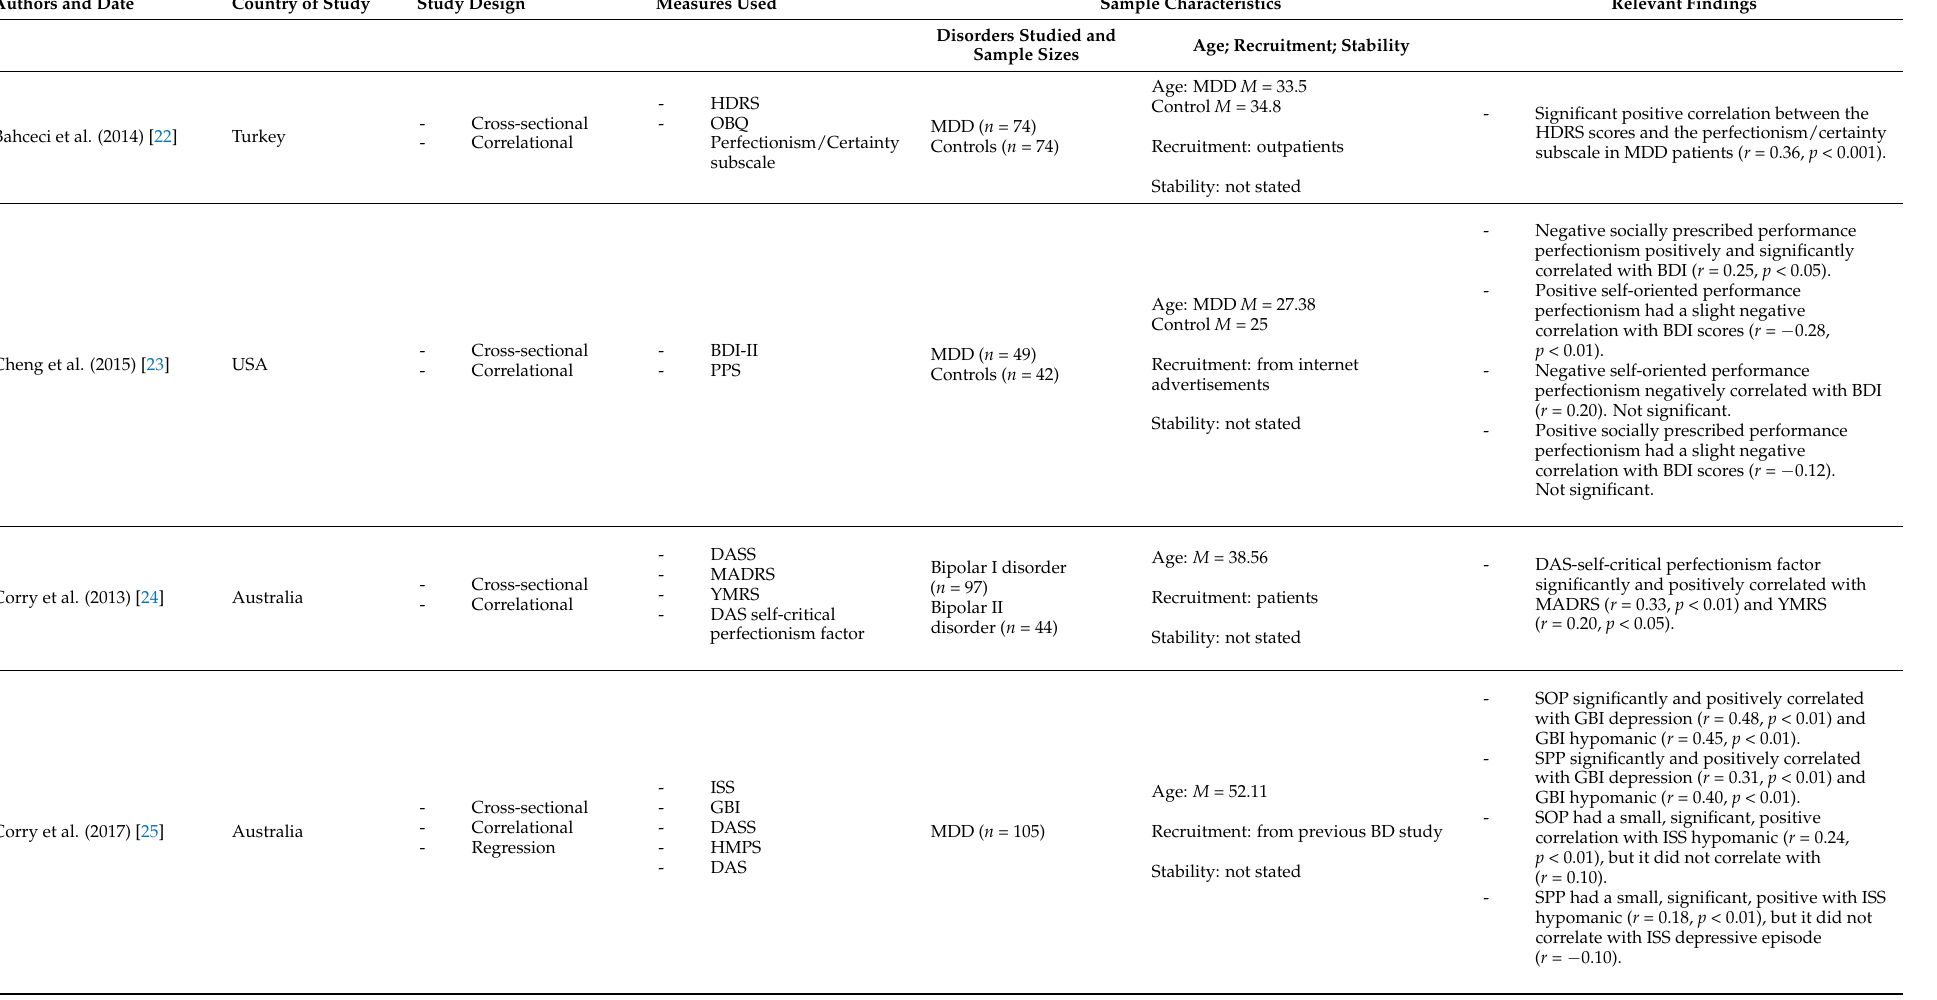
Table 1. Study Characteristics and Relevant